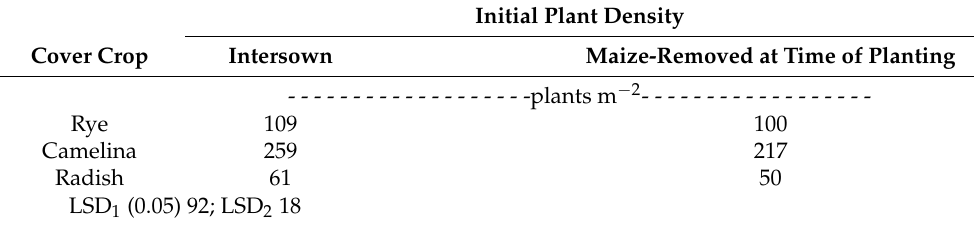
Table 3. Mean initial cover crop density for two maize-removal treatments, averaged across four environments at Casselton, Hickson, and Prosper, ND, USA, in 2018 and 2019.